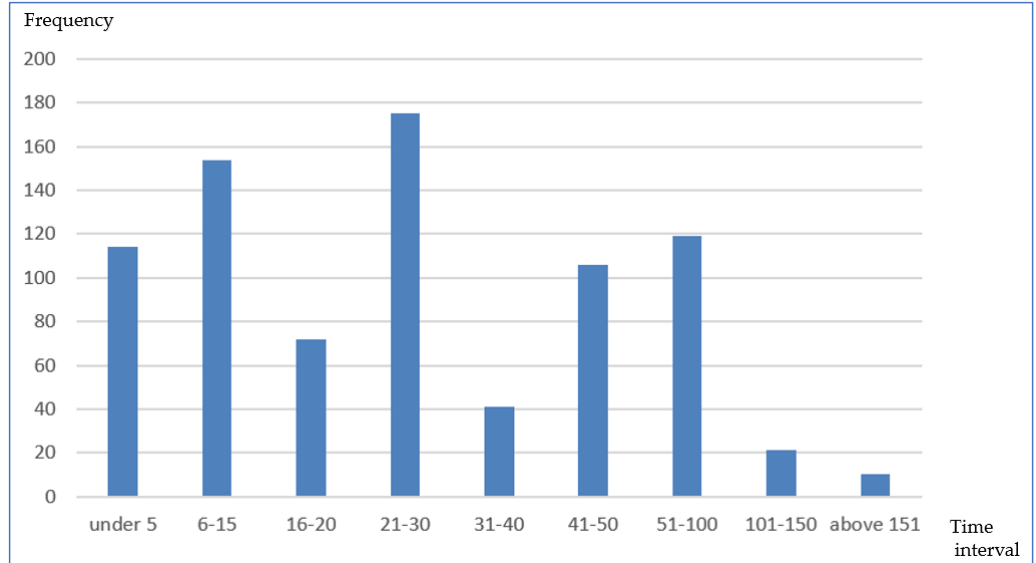
Figure 2. Distribution of ship arrival time interval of Incheon terminal.